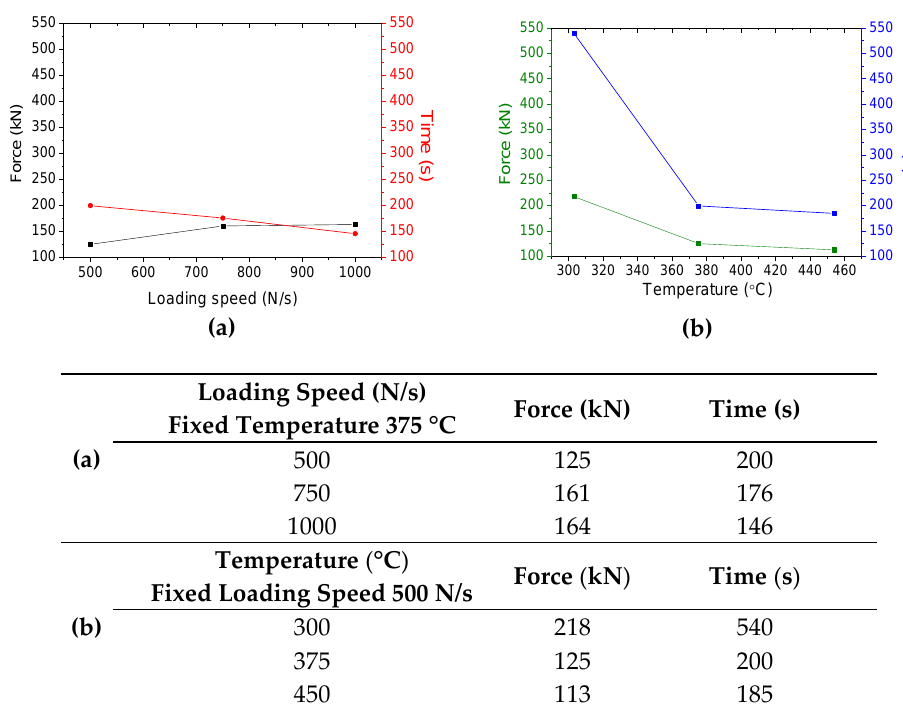
Figure 4. Study of the process parameters of the extrusion process ( a ) Force (kN) and Time (s) vs. Loading Speed (N/s) ( b ) Force (kN) and Time (s) vs Temperature ( ° C).